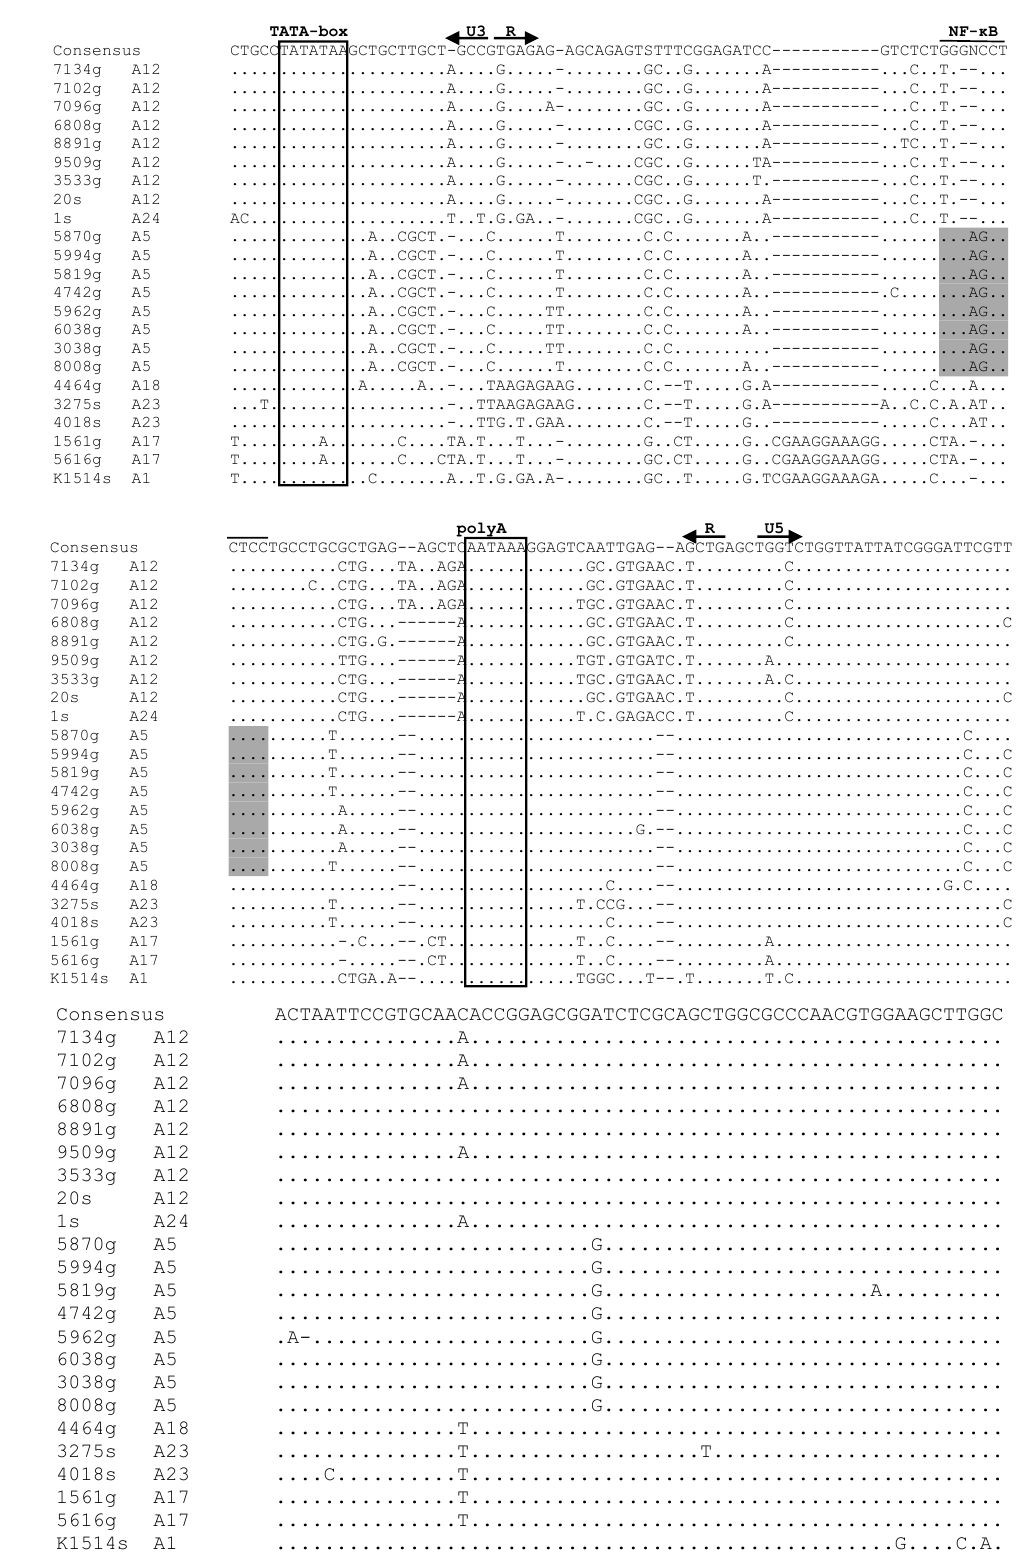
Figure 2. Alignment of U3-R sequences of the LTR region from Polish SRLV strains analyzed in this study. Dots indicate an identical nucleotide, and dashes represent gaps. Boundaries between U3, R and U5 are indicated by straight arrows. AP-1, AP-4, AML (vis) motifs, TATA box, GAS, TAS, Stat-1 and polyadenylation signal (poly A) are marked by boxes. NF- κ B, IFR-1 and CAAT are shaded and indicated by a solid bar. s — sheep; g — goat.